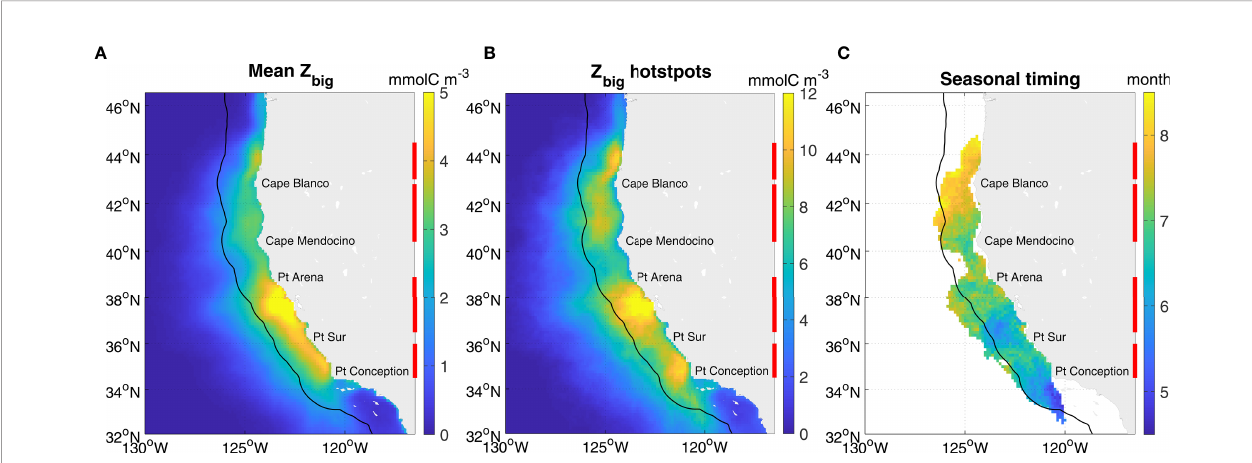
FIGURE 7 | Krill hotspots spatial distribution and timing in GA-sat (1993-2018). The maps display: (A) the mean Z big , (B) the mean yearly maximum Z big , and (C) the mean timing of the yearly maximum. For B , C values were computed at each grid cell each year, and averaged over all years. Only grid cells where the mean yearly maximum is over its 80th percentile were retained for seasonal timing. The black contour indicates the 150 km coastal band, and the red bars indicate zooplankton hotspots: northernmost 43-44.5°N, north 40.4-42.8°N, central 36.3-38.9°N, and south 34.5-36°N.